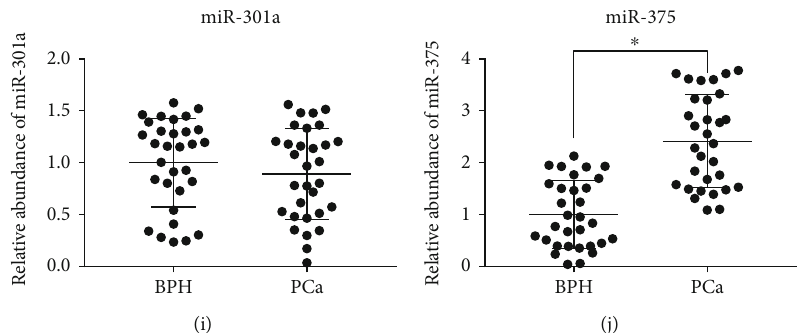
Figure 3: The relative miRNA levels in the PCa and BPH groups: (a) miR-18a, (b) miR-34a, (c) miR-106b, (d) miR-141, (e) miR-182, (f) miR- 183, (g) miR-200a, (h) miR-200b, (i) miR-301a, and (j) miR-375. ∗ P < 0 : 05 ; n = 31 .